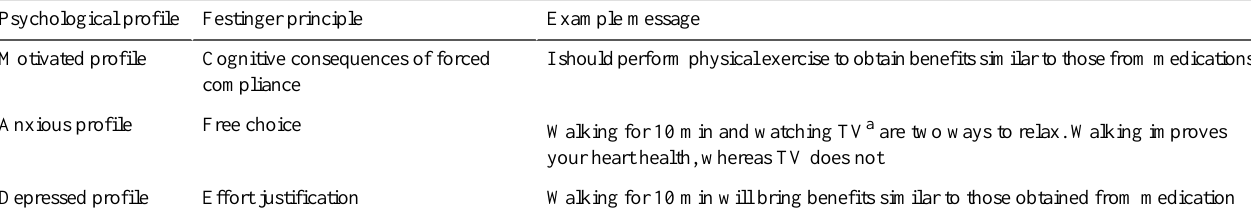
Table 1. Examples of cognitive behavioral therapy messages about physical exercises for three different psychological profiles.